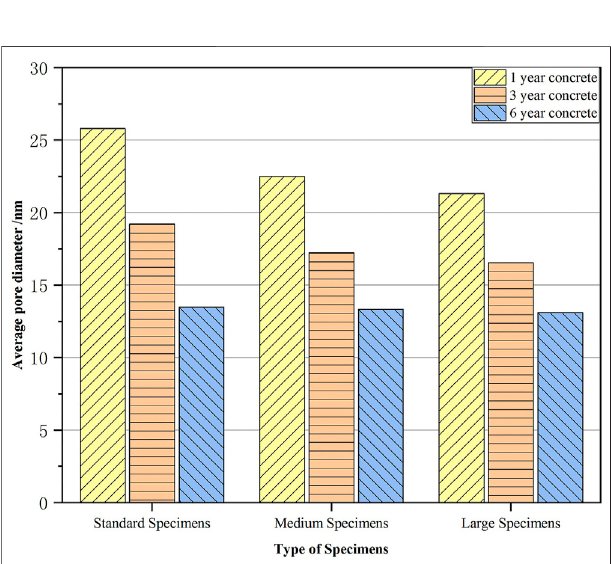
FIGURE 9 | Harmless hole with the diameter smaller than 20 nm in the concrete mixed with 6% MgO.